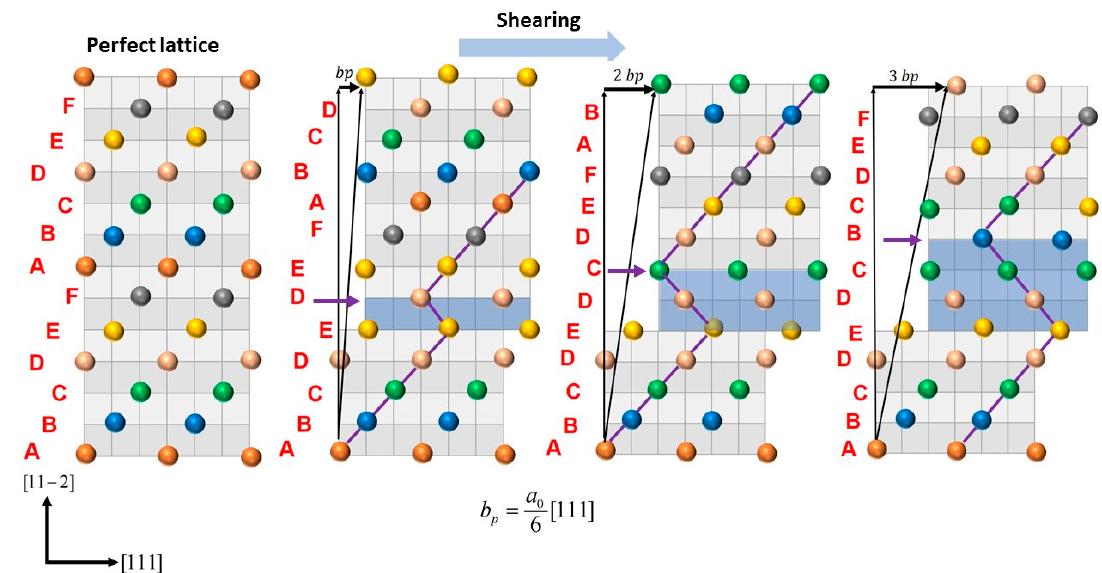
Figure A1. Schematic illustration of shearing {112} planes along [111] of bcc-Fe. Different colors of atoms in different {112} planes. The b p is the Burger’s vector of the fractional dislocation on the {112} planes. Purple arrows mark shearing direction while blue rectangles denote twinned region.